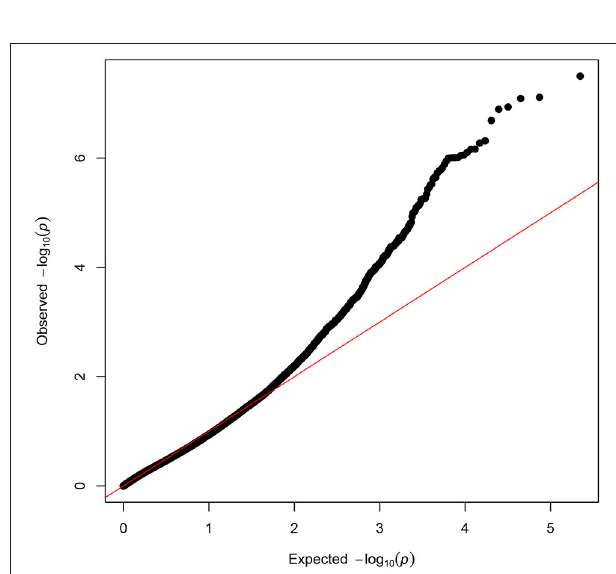
FIGURE 2 | Quantile-Quantile plot of the meta-analysis of symptoms of sleep apnea. The QQ-plot shows the observed p -values plotted on the y-axis against the expected values of the test statistics on the x-axis (X 2 -distribution). The red line shows the distribution under the null hypothesis.